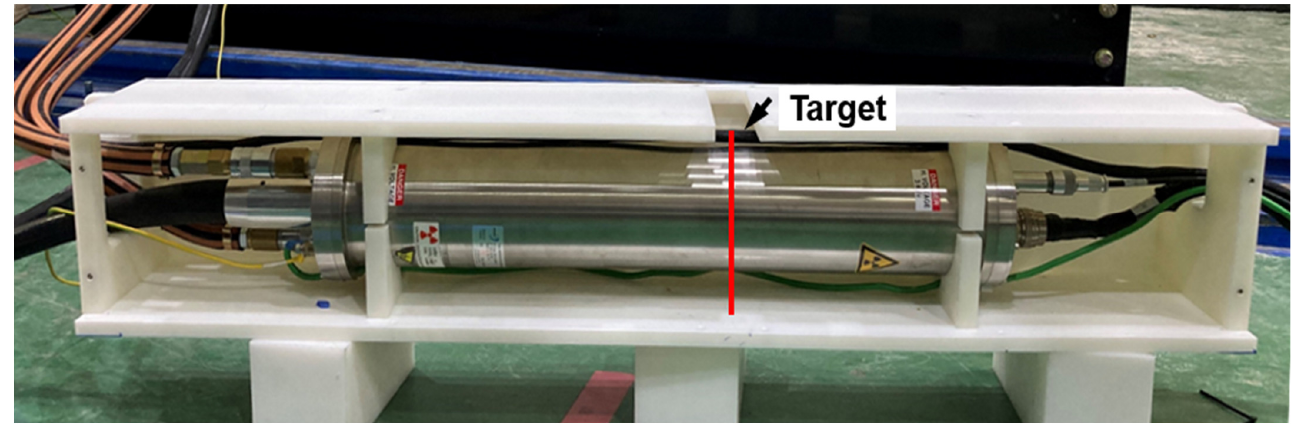
Figure 3. D-T generator. The red line in the center of the D-T generator indicates the position of the